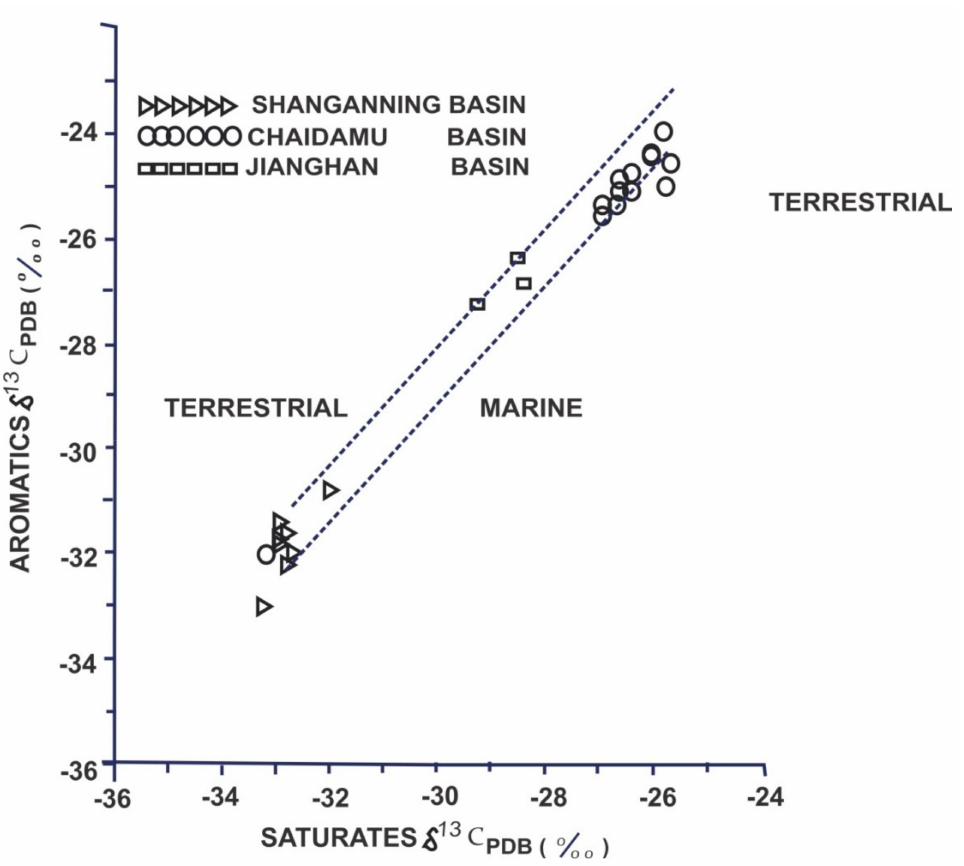
Figure 2. A plot of δ 13 C saturates versus δ 13 C aromatics (Reproduced from [91] with permission of